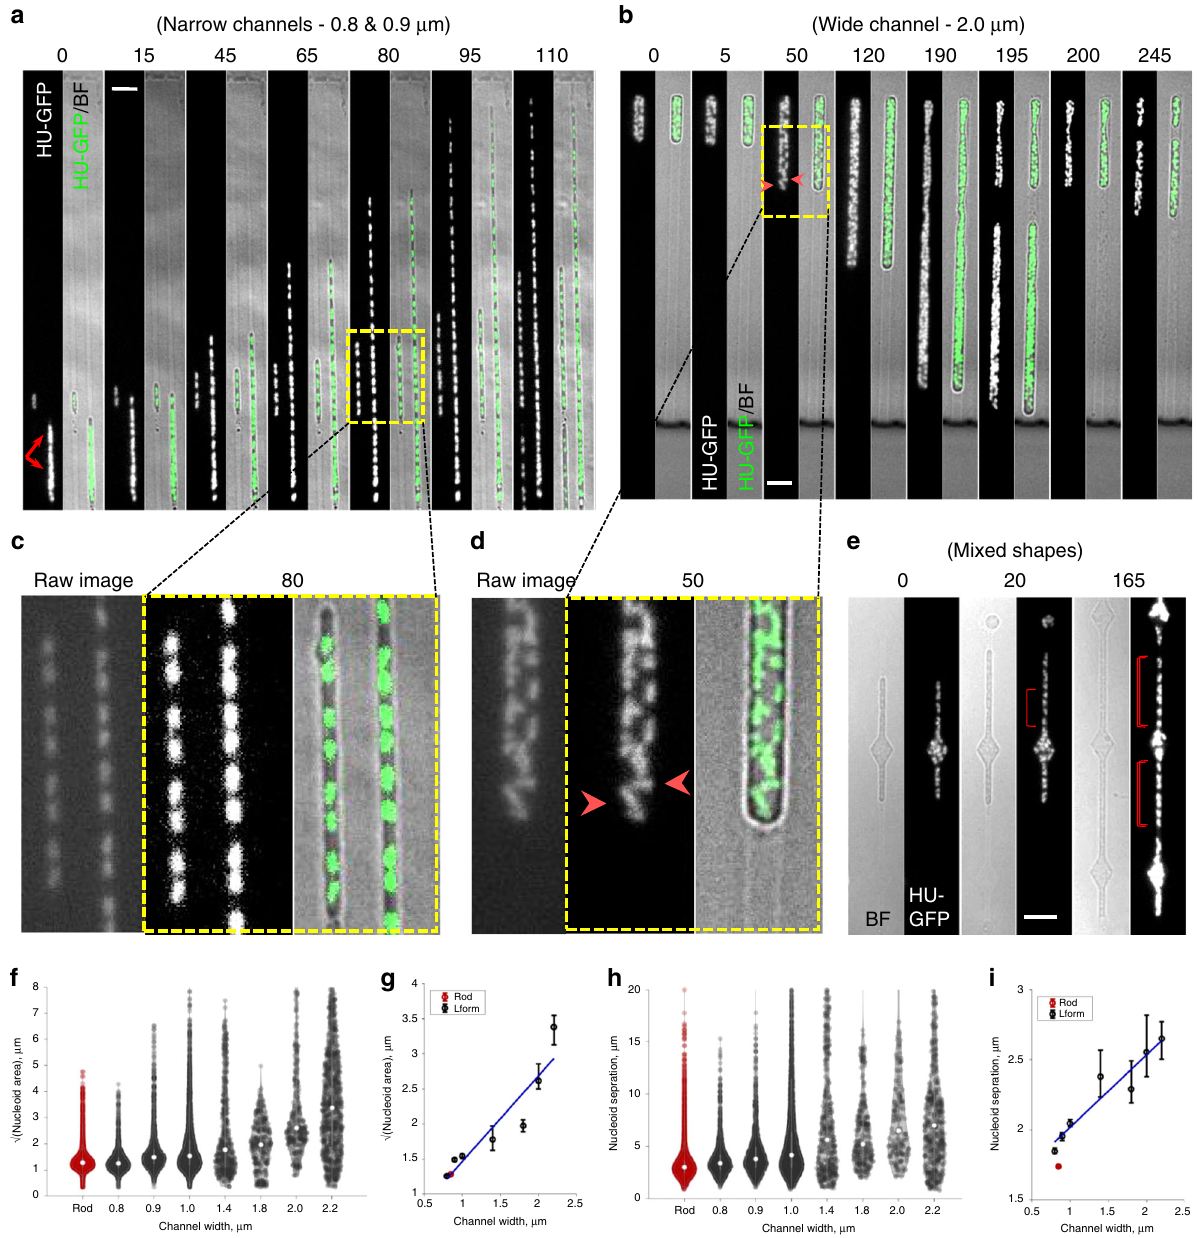
Fig. 3 Effect of channel width on nucleoid appearance and arrangement in L -forms. a , c Regular chromosome segregation in narrow micro fl uidic channels. Selected frames from the same time-lapse experiment shown in Fig. 2a. For each time frame (min) two images are presented: a HU-GFP image showing the nucleoids (left) and the merge of the GFP image (green) and the corresponding bright fi eld image (grey) (right). The small cell on the left was in a 0.9 µ m channel; the large cell on the right was in a 0.8 µ m channel. Full set of still images is shown in Supplementary Fig. 2. Yellow boxed region is enlarged and shown in Fig. 3c. An un-processed GFP image at t 80 min is shown to the left in Fig. 3c. Scale bar, 5 µ m. b , d Irregular chromosome arrangement and distribution in wide channels. Selected frames from Supplementary Movie 4. The cell shown was in a 2.0 µ m channel (Chip No. 7). Arrowheads: chromosomes lying horizontally or perpendicularly. Strain: 4739 (LR2 Ω amyE :: neo hbsU-gfp ). Yellow boxed region is enlarged and shown in Fig. 3d. An un-processed GFP image at t50 min is shown to the left in Fig. 3d. Scale bar, 5 µ m. More time frames are shown in Supplementary Figure 3a. e Chromosome arrangement in Chip No. 33, which contained alternating narrow channels and diamond shapes. These are selected frames from Supplementary Movie 6, showing a bright fi eld image on the left and chromosomal DNA (HU-GFP) on the right. Strain: 4741 (LR2 Ω amyE :: neo hbsU-gfp aprE::P rpsD -mcherry spc) . Brackets indicate regions where chromosomes appear regularly distributed. Scale bars, 5 µ m. More time frames are shown in Supplementary Fig. 3c. Each experiment was performed at least twice independently, and imaged at multiple positions, with similar results. f – i Quantitative analysis shows that spatial con fi nement of L -forms can reproduce near- native nucleoid segregation. f Nucleoid size, as measured by the square root of nucleoid area, for walled cells (Rod, red) and L -forms in different channel widths (black). g Scatter plot of square root of nucleoid area versus channel width for walled cells (red) and L -forms (black). h Nucleoid separation for walled cells (Rod, red) and L -forms in different channel widths (black). i Scatter plot of nucleoid separation vs. channel width. Blue line in g and i : linear fi t to the L -form data. For walled cells (red) in g and i , the “ channel width ” was set to 850nm to match the known cell width. Violin plots: Circles indicate the median. Scatter plots: Circles indicate the median, error bars indicated 95% con fi dence interval from bootstrapping. n = 17,766 time-lapse observations of nucleoids descended from 45 mother cells in separate agarose channels. Source data are provided as a Source Data fi